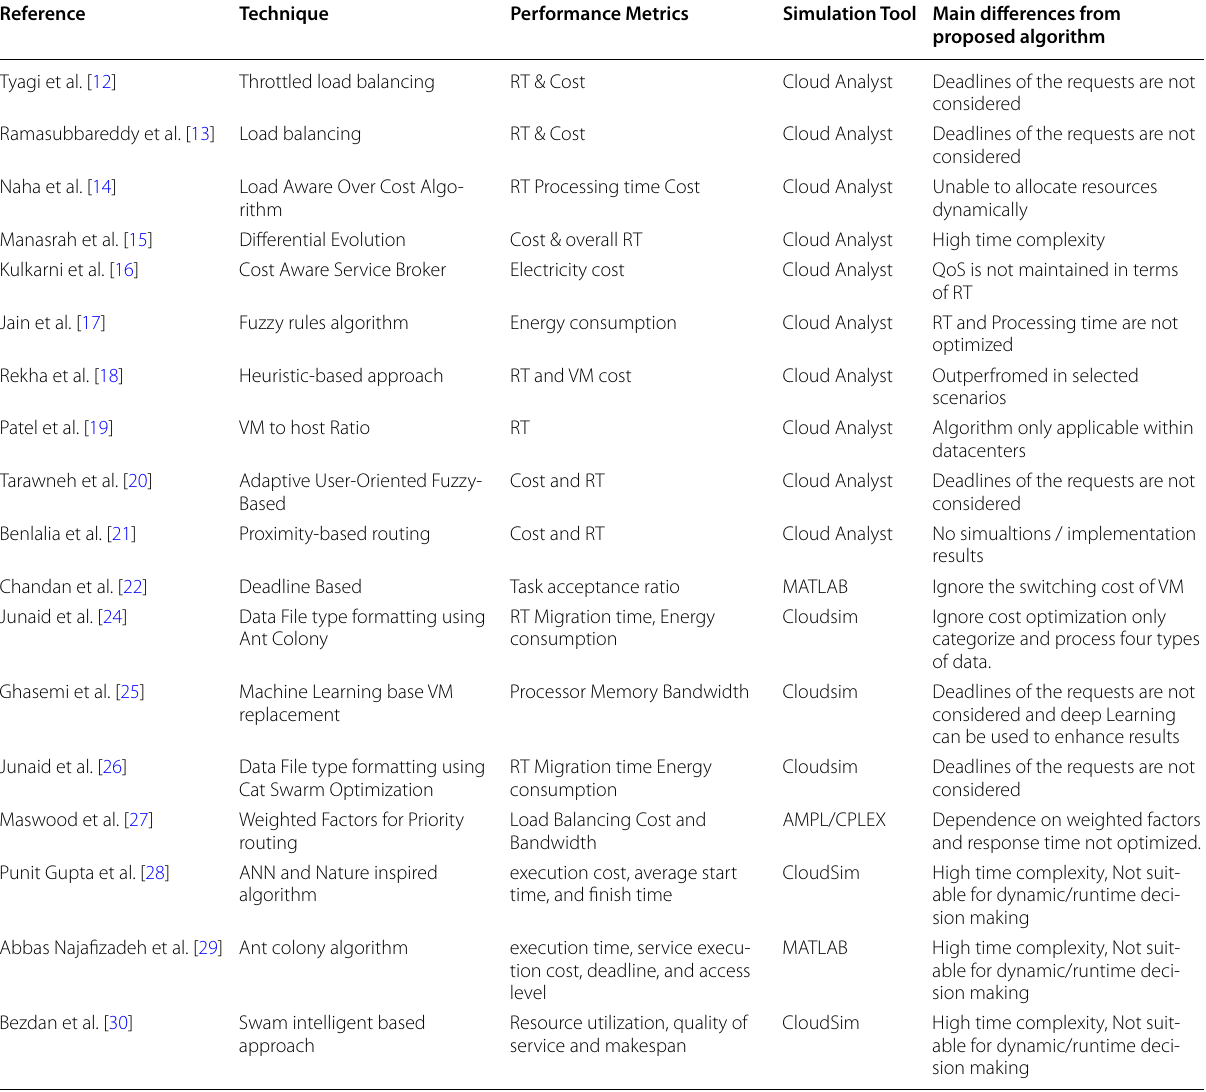
Table 1 Summary of relevant